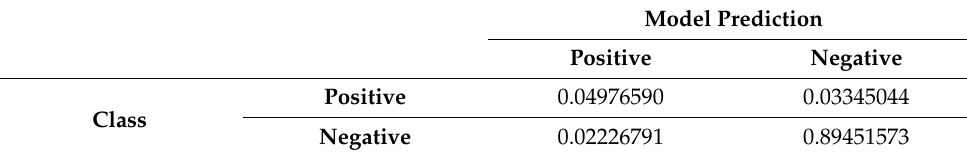
Table 4. Confusion matrix (Conventional U-Net/ small number of particles).